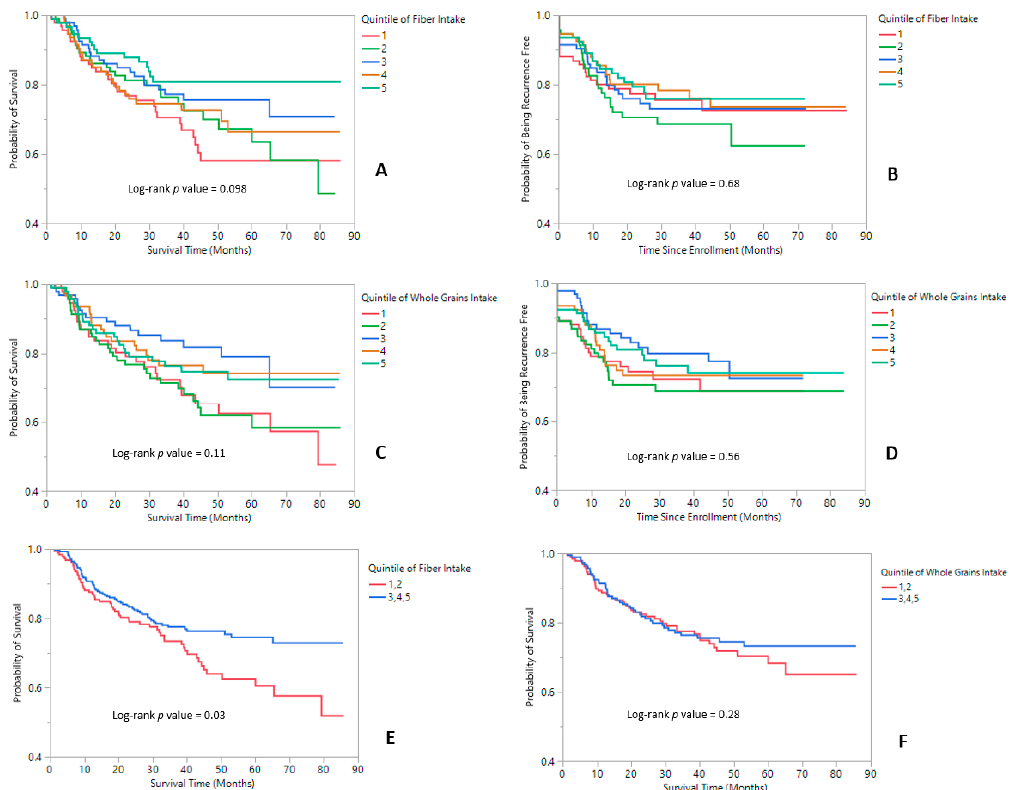
Figure 1. Kaplan–Meier Survival function plots for survival and recurrence. ( A ) Survival according to the quintile of fiber intake. ( B ) Recurrence according to fiber intake. ( C ) Survival according to whole grain intake. ( D ) Recurrence according to whole grain intake. ( E ) Survival according to a binary predictor (collapsing quintiles 1 and 2 or 3, 4, and 5 into separate categories) of fiber intake. ( F ) Survival according to a binary predictor (collapsing quintiles 1 and 2 or 3, 4, and 5 into separate categories) of whole grain intake.